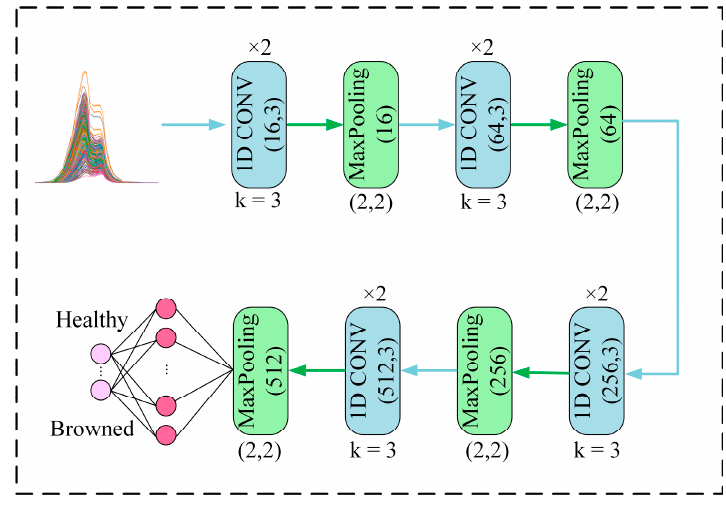
Figure 4. The flow chart of the network framework of the 1D-CNN model.